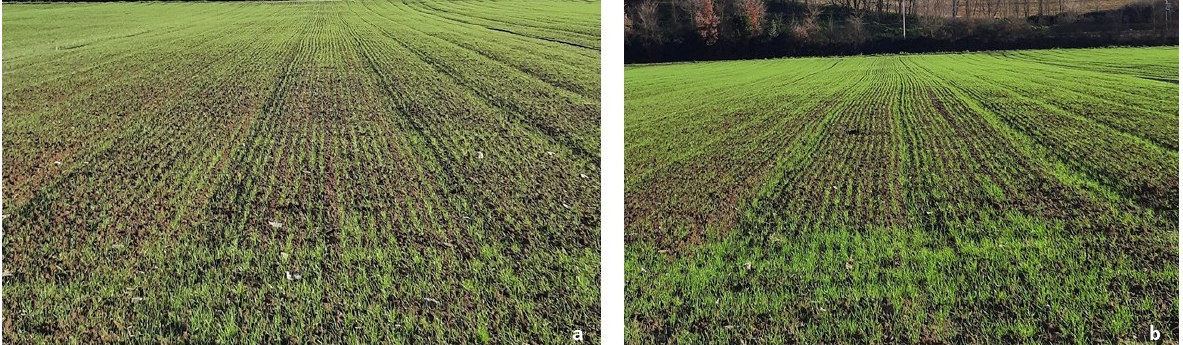
Figure 2. ( a ) Field sown in semi-automatic guidance (SG); ( b ) field sown with in manual guidance (MG).